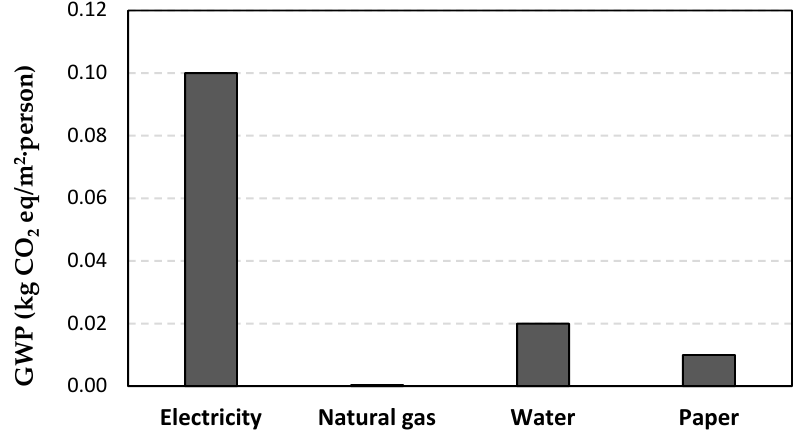
Figure 9. Contribution of the different flows to the total global warming potential (GWP).